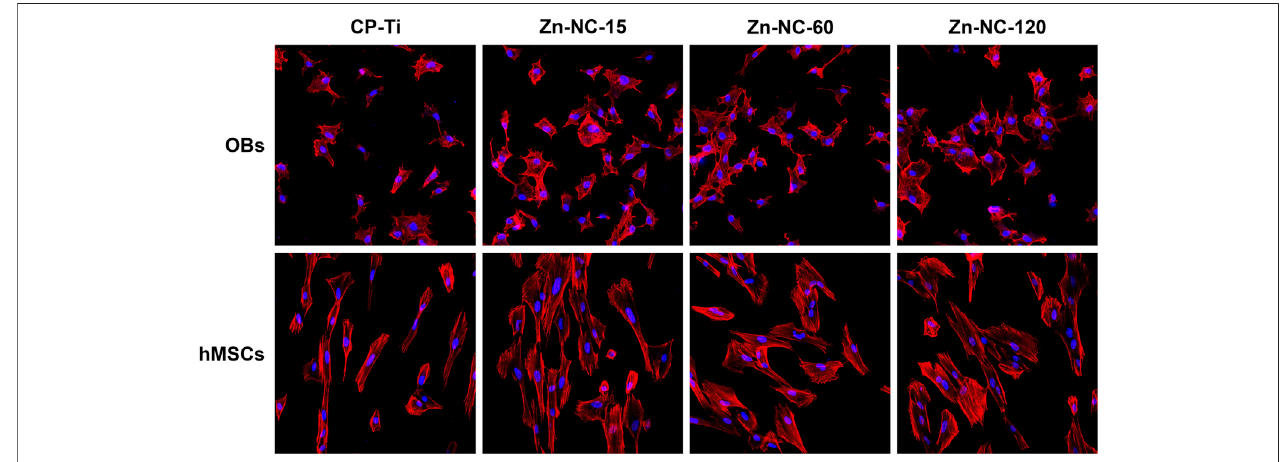
FIGURE 8 | LSCM images of OBs cultured for 8 h and hMSCs cultured for 24 h on the different surfaces at × 200 magni fi cation.